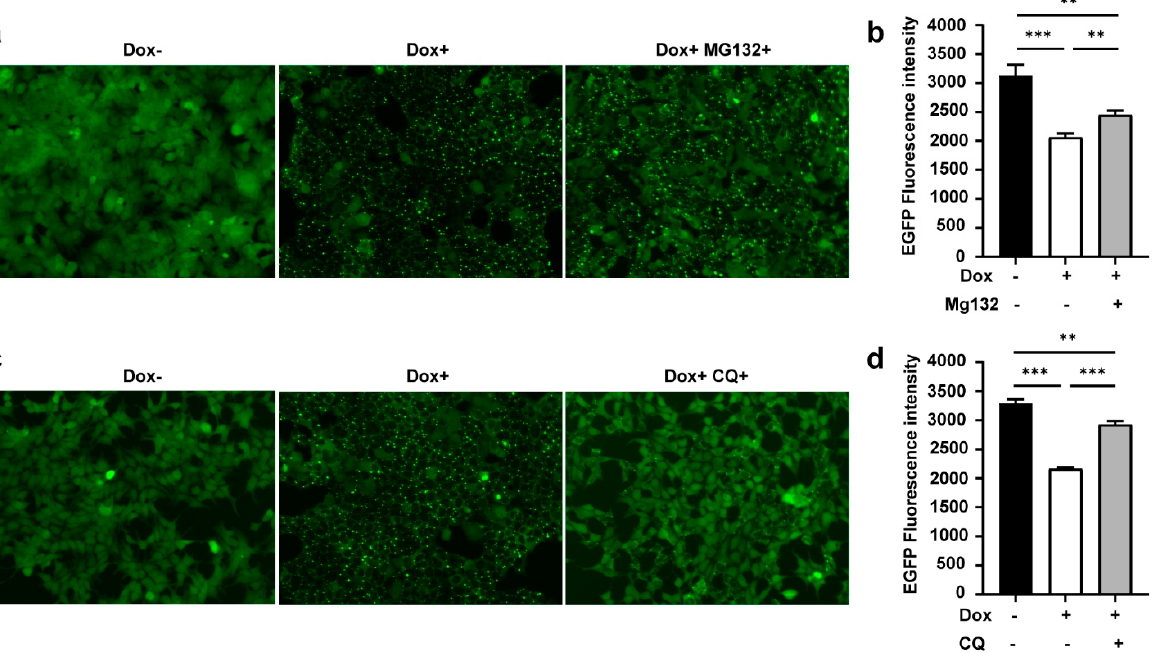
Figure 4. TRIMbody induced ubiquitination and proteasome-mediated degradation of EGFP. ( a ) Effect of proteasome inhibitor MG132 on degradation of EGFP. ( b ) Average fluorescence intensity of EGFP in cells untreated or treated with Dox or MG132 was measured using flow cytometry and indicated by bar graphs ( n = 3 replicates per group). Data represent the mean ± SEM. ** p < 0.01 and *** p < 0.001 represent statistical significance. ( c ) Effect of autophagy–lysosome inhib- itor Chloroquine (CQ) on degradation of EGFP. ( d ) Average fluorescence intensity of EGFP in cells untreated or treated with Dox or Chloroquine (CQ) was measured using flow cytometry and indicated by bar graphs ( n = 3 replicates per group). Data represent the mean ± SEM. ** p < 0.01 and *** p < 0.001 represent statistical significance. 4. Discussion Examining gene function in different cell types or tissues exists in at least three layers of perturbation, including DNA modification, RNA interference, and protein degradation [37,38]. However, the utility of DNA/RNA editing methods can be limited by reducing of the target protein through a long time of process including DNA/RNA-targeted excision and protein turnover, which may delay the manifestation of phenotypes and activate a compensatory mechanism. In contrast, techniques for disrupting intracellular protein en- able the direct analysis of its biological function. Recently, TRIM-Away, a promising ap- proach to degrade endogenous proteins acutely and rapidly in mammalian cells, was de- veloped to remove unmodified native proteins by microinjection of anti-targets antibodies and TRIM21 protein into cells. However, the difficulty on manipulations of a bulk cell population limited its extensive application. In addition, it was reported that TRIM21 is involved in the regulation of innate immunity and the inflammatory IFN pathway [39,40]. Thus, exogenous induction of TRIM21 by microinjection or electrotransfection needs rig- orous investigation. The relatively large size of the full-size mAbs (150 kDa) results in correspondingly low tissue penetration and inaccessibility of some sterically hindered epitopes, which further limits the degrading efficacy of endogenous protein by Trim- Away Technology. In order to resolve the concern of potential side effects of full-size mAbs and TRIM21, we established an alternative approach by fusing of the function RBCC domain of TRIM21, containing E3 ubiquitin ligase motif, with the fragment of anti- EGFP nanobody, to target intracellular EGFP for degradation. Next, by transient transfection and Tet-on inducible expression of α EGFP TRIMbody in stable EGFP-expressing HEK293T, we revealed the intracellular EGFP degradation me- diated by α EGFP TRIMbody in a time-dependent pattern. Moreover, by examination of